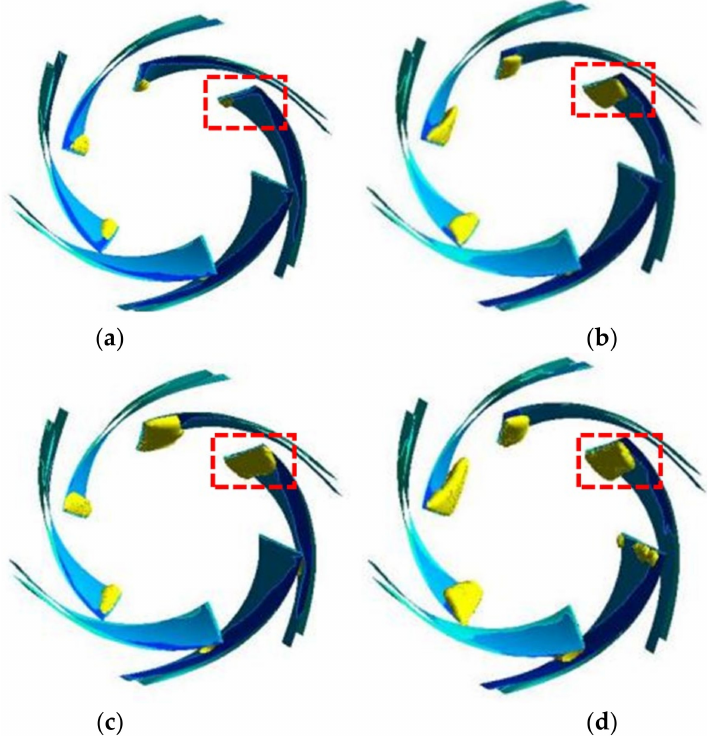
Figure 11. Cavitation distribution under different working conditions: ( a ) 500 m 3 /h; ( b ) 800 m 3 /h; ( c ) 1000 m 3 /h; ( d ) 1100 m 3